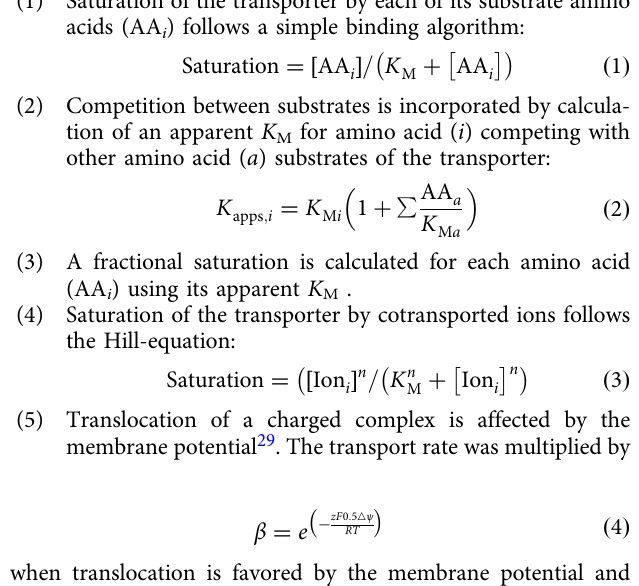
Fig. 2 Discrimination of amino acid transport activities in U87-MG glioma cells. The transport of [ 14 C]amino acids is shown for a leucine (100 µ M, 2 min, n [by column] = 12,12,12, 6, 12, 12, 12, 10, 12, 12, 15, 6; e = 3), b glutamine (100 µ M, 2 min, n = 12, 7, 9, 7, 8, 6, 6, 12, 11, 6; e = 3), c alanine (300 µ M, 2 min, n = 18, 9, 9, 10, 6, 6, 9, 11, 13, 15; e = 3), d proline (100 µ M, 6 min, n = 12, 6, 6, 6, 6, 6, 9, 6; e = 3), e glycine (100 µ M, 6 min, n = 10, 9, 6, 6, 6, 6, 6, 6; e = 3), f glutamate (100 µ M, 6 min, n = 6, 6, 9, 7, 7; e = 3), and g arginine (100 µ M, 6 min, n = 9, 8, 9, 9, 8, e = 3). AA uptake was measured in Na + -based buffer (white squares above the bars), NMDG + -based buffer (black squares above the bars), or Li + -based buffer (gray squares above the bars). In the